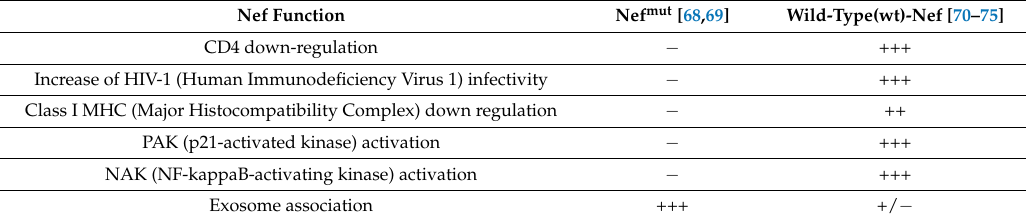
Table 2. Comparison between the Nef mut and the wild type Nef